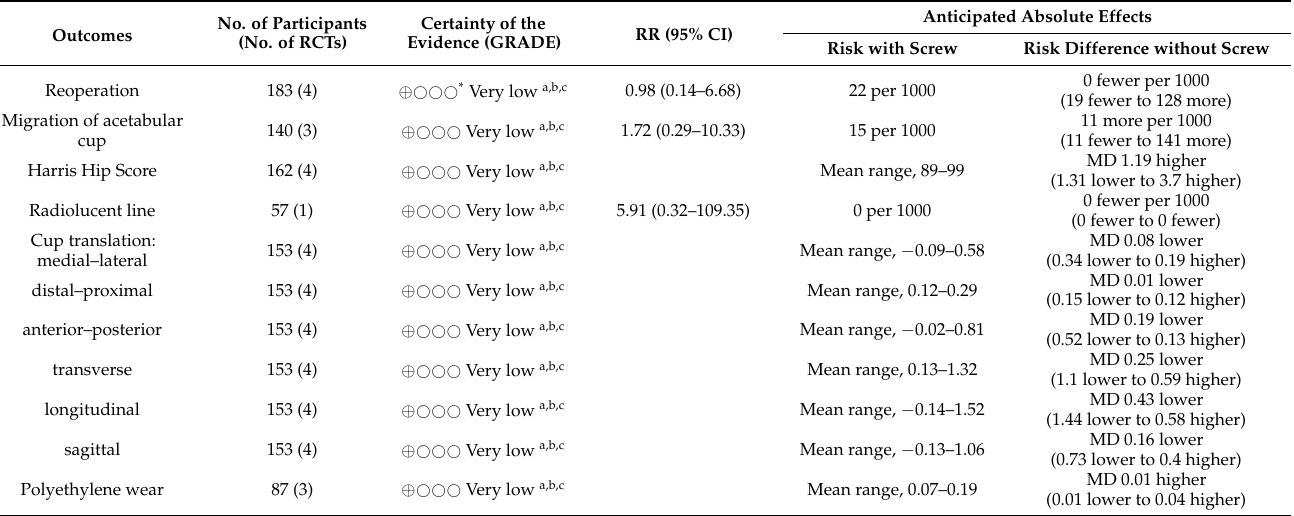
Table 2. Summary of